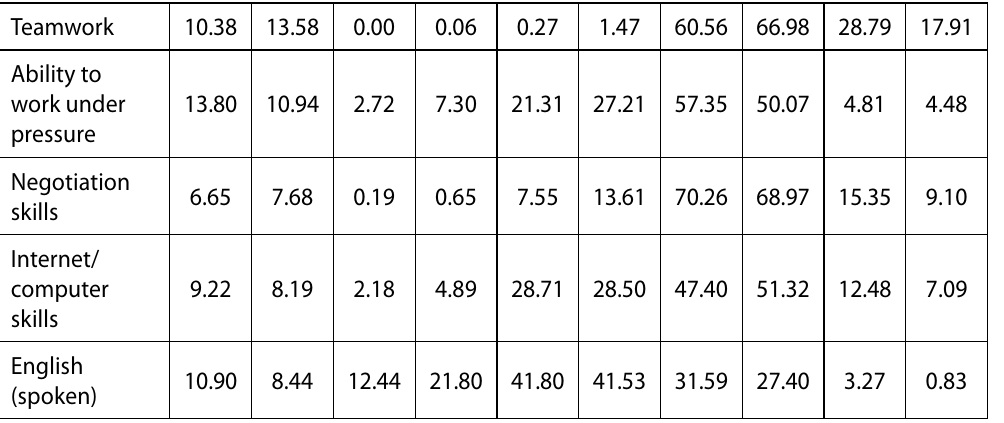
Table 7 Perceptions of employers and graduates concerning graduate competency aspects (percentage)